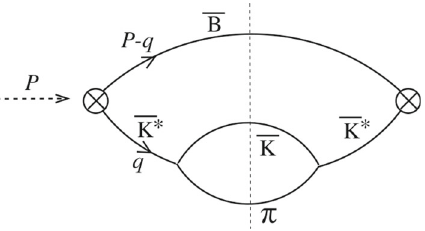
Fig. 5 ¯ B ¯ K ∗ loop considering the K ∗ → K π decay. The cut shown is the source of the imaginary part of the unitarized ¯ B ¯ K ∗ scattering